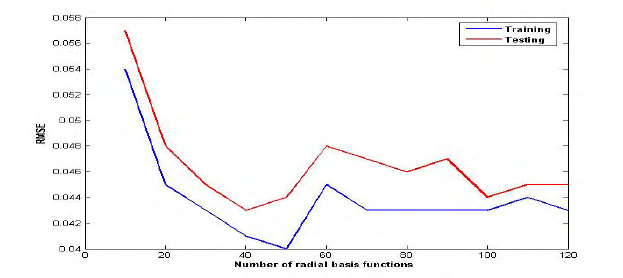
Fig. 8. The effect of the cluster number - Mackey